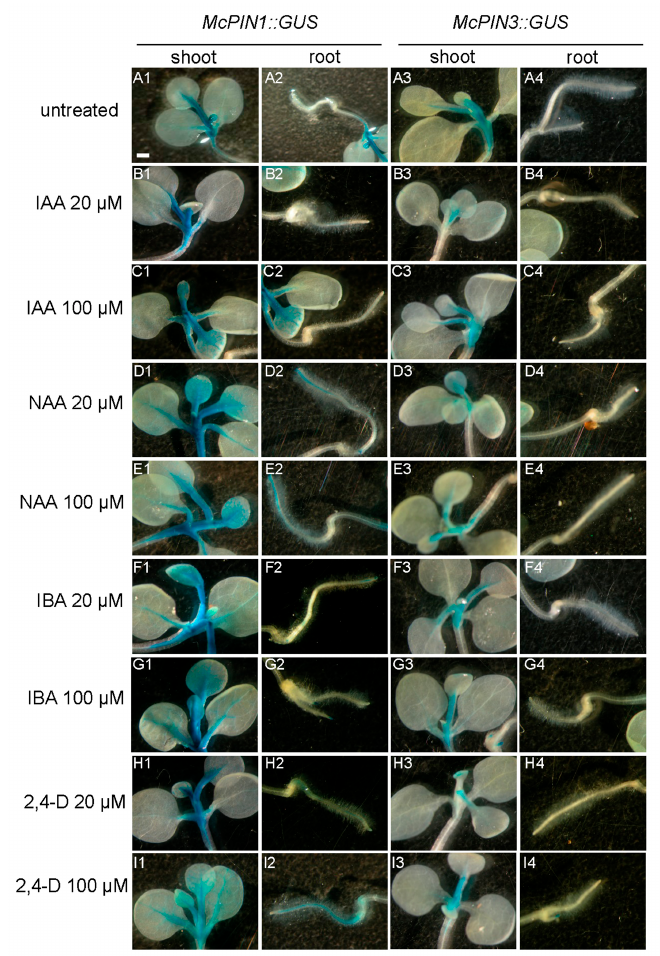
Figure 7. Effect of auxins on the expression in tobacco McPINpro::GUS gene promoter transgenic seedlings. Four-week-old seedlings were treated with different kinds of auxins at 20 or 100 µM for 24 h. ( A ) Untreated seedlings as a negative control; ( B ) 20 µM IAA; ( C ) 100 µM IAA; ( D ) 20 µM NAA; ( E ) 100 µM NAA; ( F ) 20 µM IBA; ( G ) 100 µM IBA; ( H ) 20 µM 2,4-D; ( I ) 100 µM 2,4-D. (1) and (2) respectively denote the shoot and root of McPIN1pro::GUS transgenic tobacco; (3) and (4) respectively denote the shoot and root of McPIN3pro::GUS transgenic tobacco. Scale bars of McPIN::GUS as A1, Scale bars: 0.1 cm.